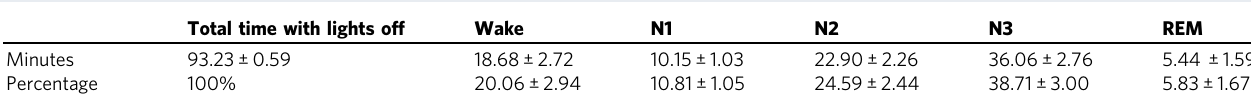
Table 1 Sleep architecture (mean ±